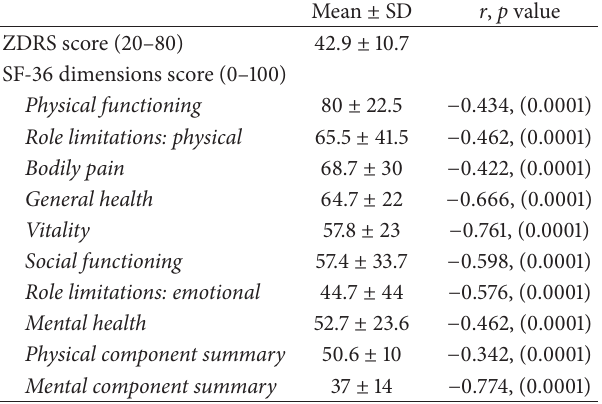
Table 3: Depression (ZDRS) and quality of life (SF-36) scores of the caregivers and correlation coefficients between ZDRS and